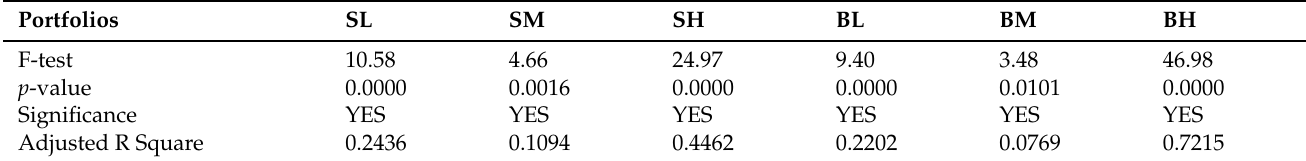
Table 8. Carhart Four-Factor Regression